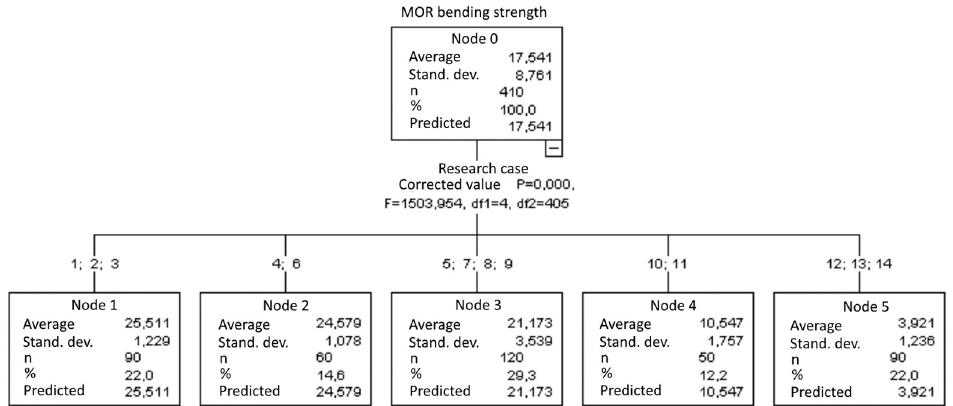
Figure 29. Classification tree for MOR bending strength.